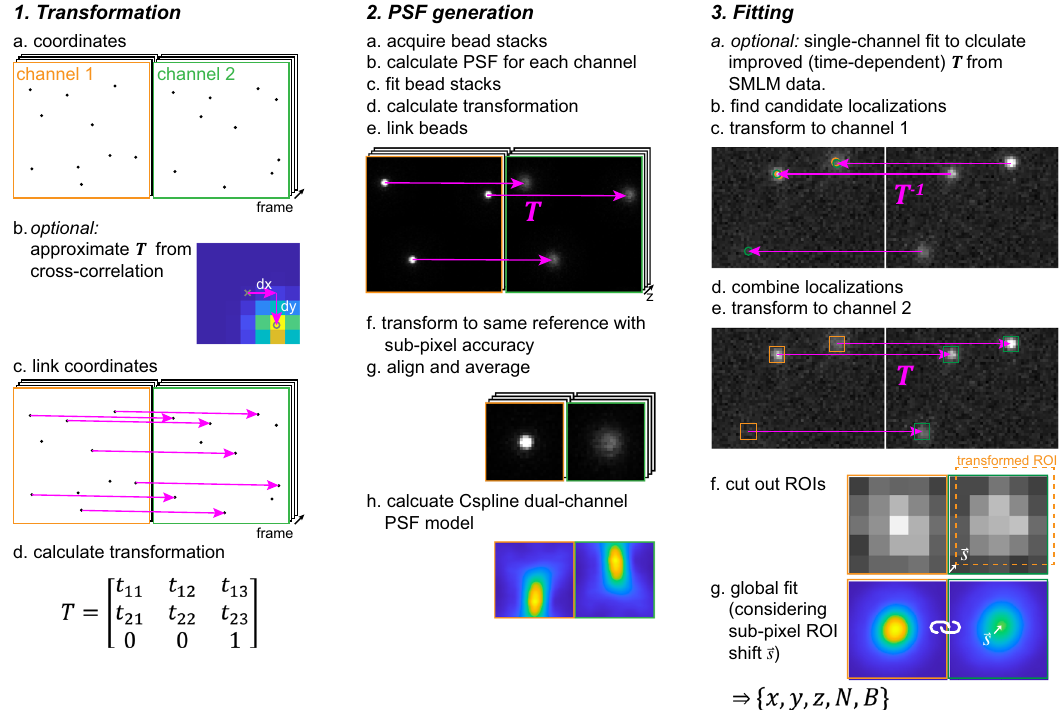
Fig. 1 Overview of work fl ow of globLoc algorithm. The overall work fl ow of globLoc can be divided into three parts: 1. calculation of multi-channel transformation using control points from beads or single molecule data; 2. generation of multi-channel PSF models by properly averaging beads from multiple channels; 3. fi tting of the multi-channel single molecule data using global maximum likelihood estimation with fl exible parameter